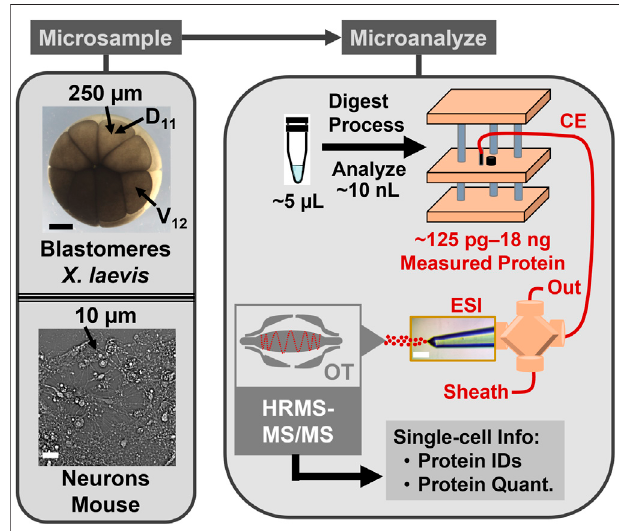
FIGURE 1 | CE-HRMS for scalable single-cell proteomics. The protein content was collected from identi fi ed cells in Xenopus laevis embryos and neurons cultured from the mouse hippocampus. The example labels the normally neural-tissue fated dorsal-animal midline cell (D 11 ) and the normally epidermally fated ventral-animal equatorial cell (V 12 ). The proteins weredetectedon a custom-built microanalytical capillary electrophoresis